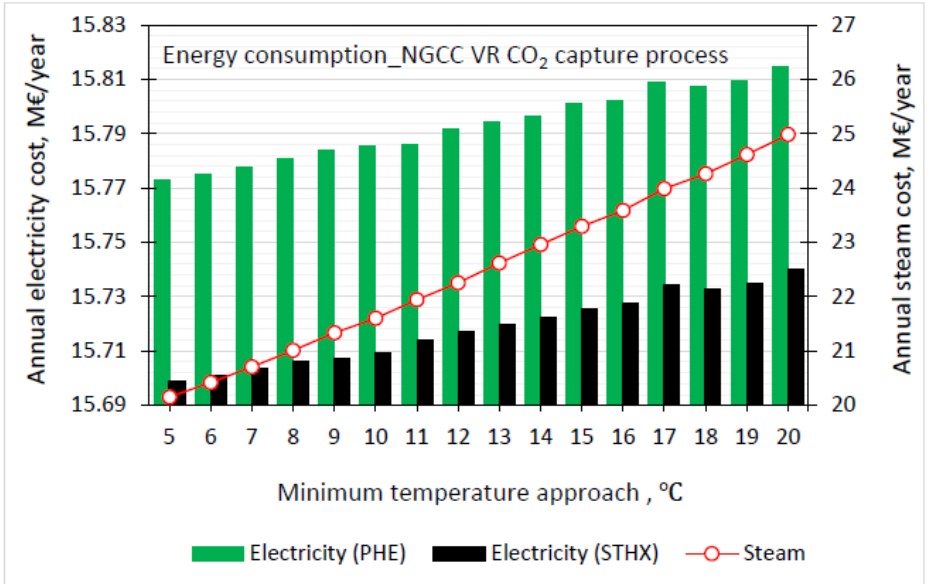
Figure 5. Energy consumption cost as a function of ∆ T min of the lean/rich heat exchanger.